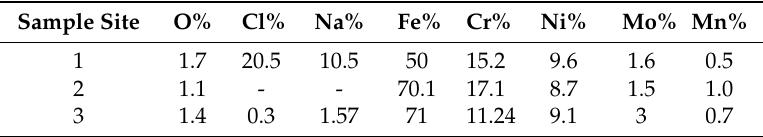
Table 6. EDX chemical analysis and resulting weight percentage of SS 316L sample in the weld zone, 100 h testing.